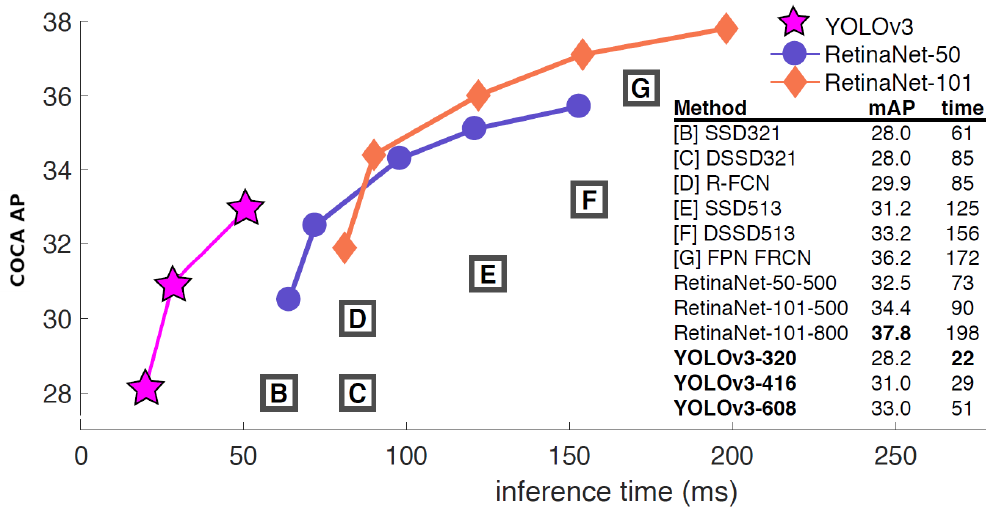
Figure 6. YOLOv3 significantly outperforms other detection methods with comparable accuracy in terms of computation time. Test results based on computations on a NVIDIA Titan X GPU evaluating images from the COCO dataset. Source